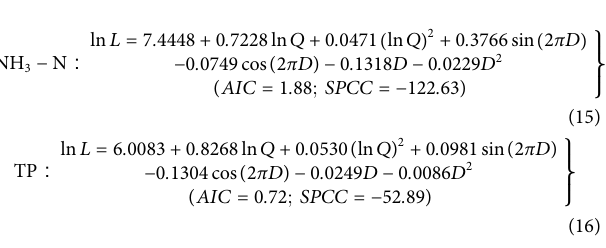
Frontiers in Environmental Science |